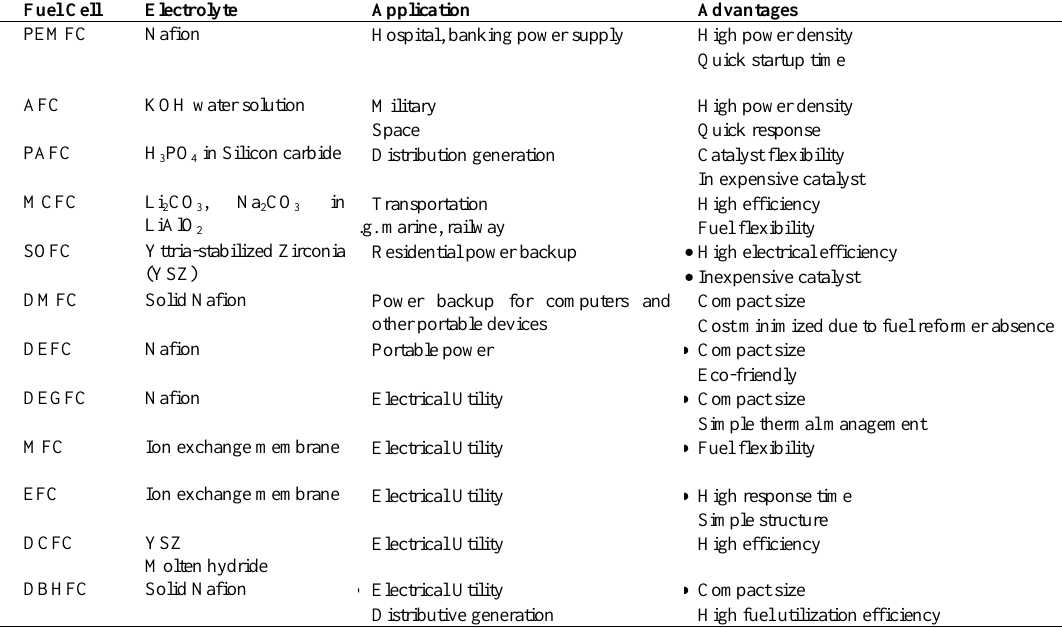
Table 2. Operating parameters of various FCs with applications and